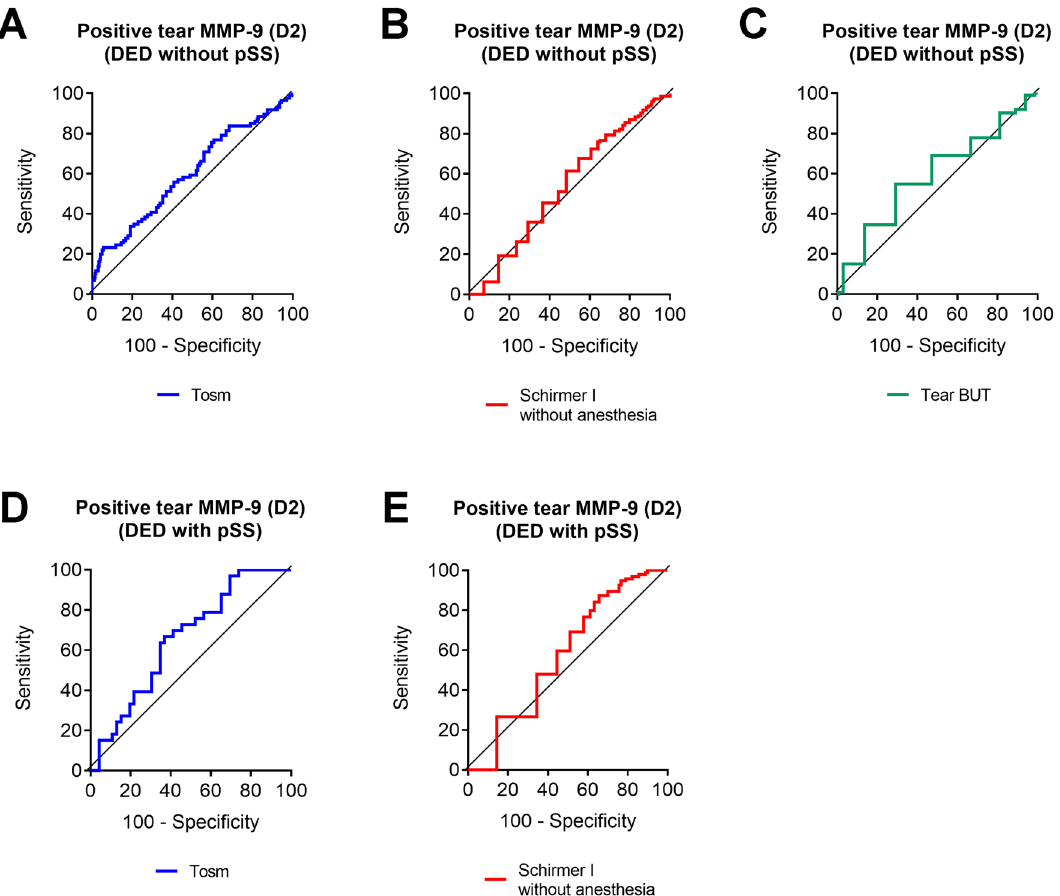
Figure 1. Receiver operating characteristic (ROC) curve analysis of tear osmolarity (Tosm), Schirmer I without anesthesia, and/or tear break-up time (BUT) in dry eye disease (DED) patients with and without primary Sjogren’s syndrome (pSS) and their association with positive tear matrix metalloproteinase (MMP)-9 by D2 dichotomous grading